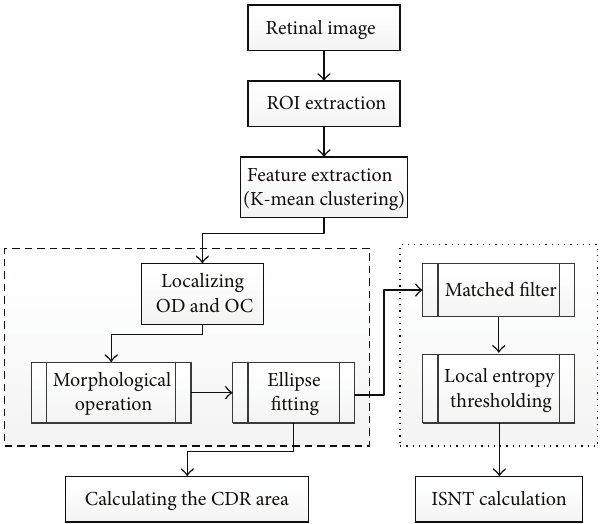
Figure 39: Flowchart for algorithm proposed in